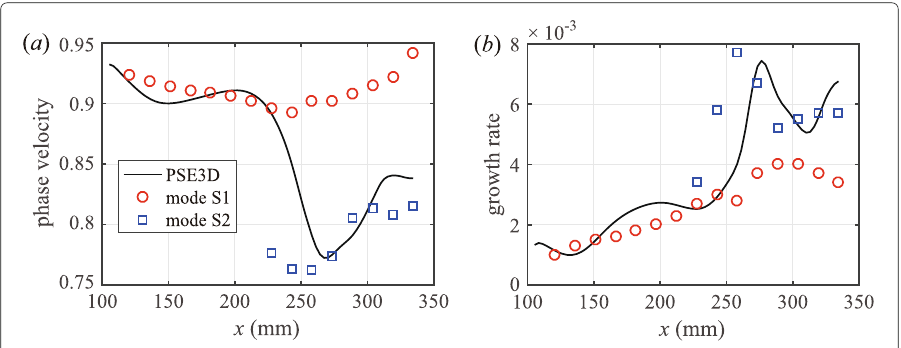
Fig. 7 PSE3D results showing the evolution of phase velocity ( a ) and growth rate ( b ) for the first-sinuous mode with frequency of 95 kHz. The BiGlobal results are indicated by the